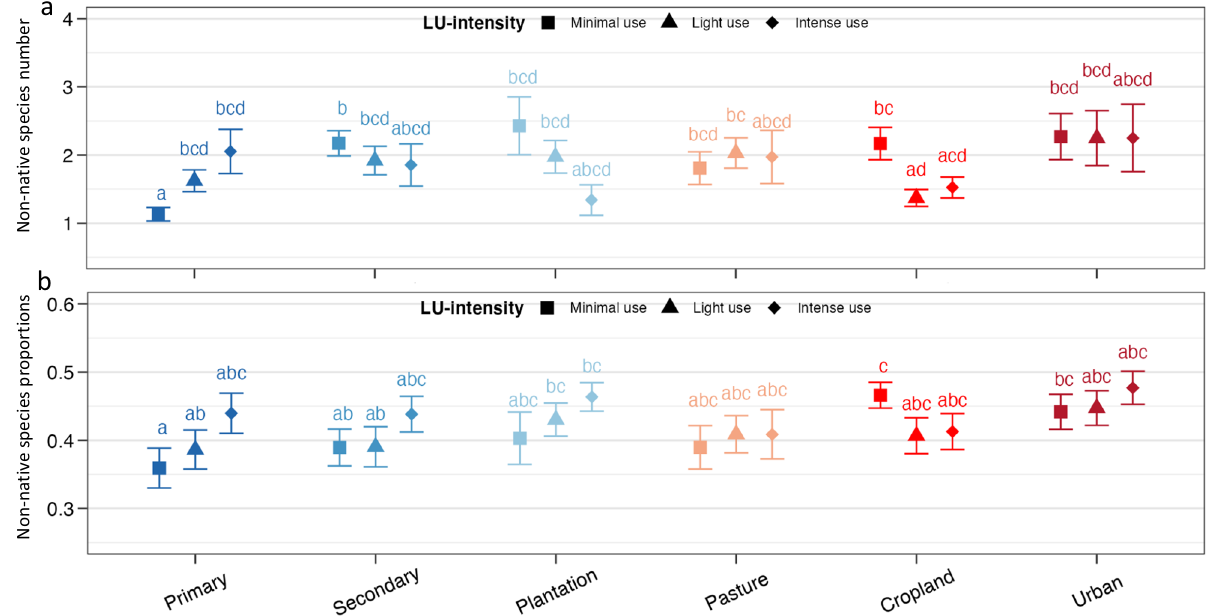
Fig.3|Numberofnon-nativespeciesandtheirproportioninlocalassemblages in response to LU-type, LU-intensity and their interaction, analysed across all fi ve taxa. The values in a and b are back-transformed estimates (means and standard errors) from a generalised linear mixed effects model (GLMM) with an